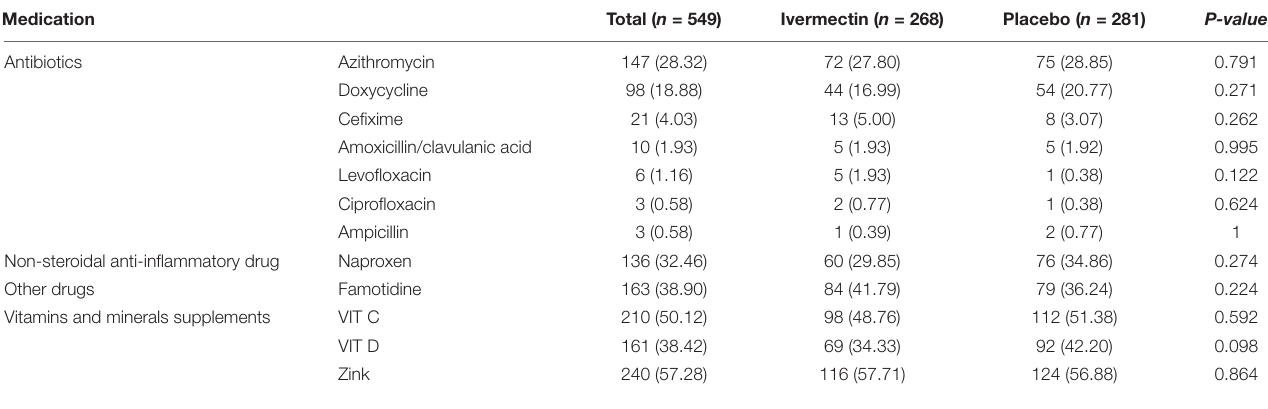
TABLE 6 | List of concomitant medications, vitamins and minerals supplements prescribed for